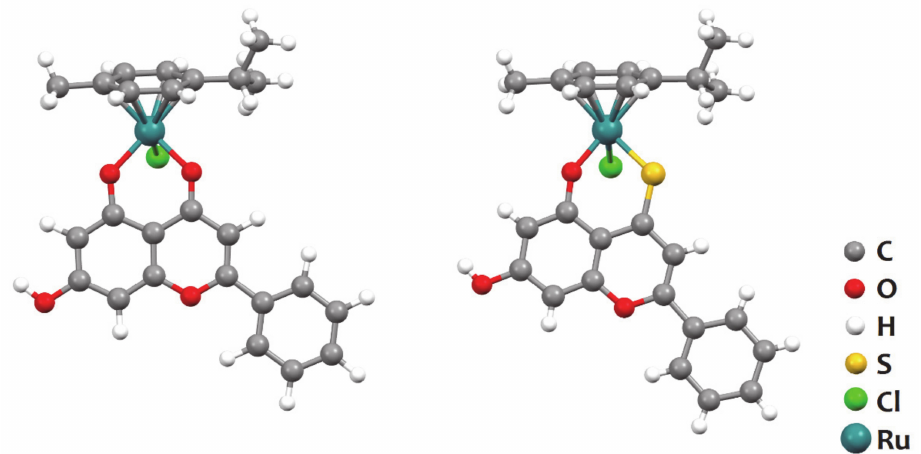
Figure 13. Structures of [Ru( p -cym)(chrysin)Cl] (left) and [Ru( p -cym)(thiochrysin)Cl] (right), where thiochrysin stands for 5-oxo-7-hydroxy-2-phenyl-4 H -chromen-4-thionate. The structures are repre- sented using the ball-and-stick style. Redrawn from the atomic coordinates available at the CCDC (refcodes KAYHAW and KAYHEA, respectively) using the software Mercury